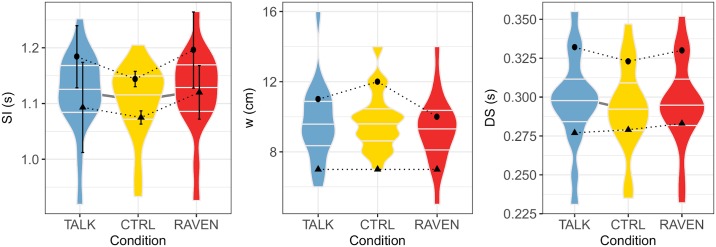
Violin plots of the spatio-temporal indicators SI, w and DS versus experimental conditions.The maximal and minimal data set the limits of the violin plots, and the median, first and third quartiles are also shown (horizontal bars). Significant differences between two conditions are marked by a gray line linking the concerned violin plots. The behaviour of two participants (3, circles, and 8, triangles) when going from CTRL condition to TALK or RAVEN conditions is displayed.